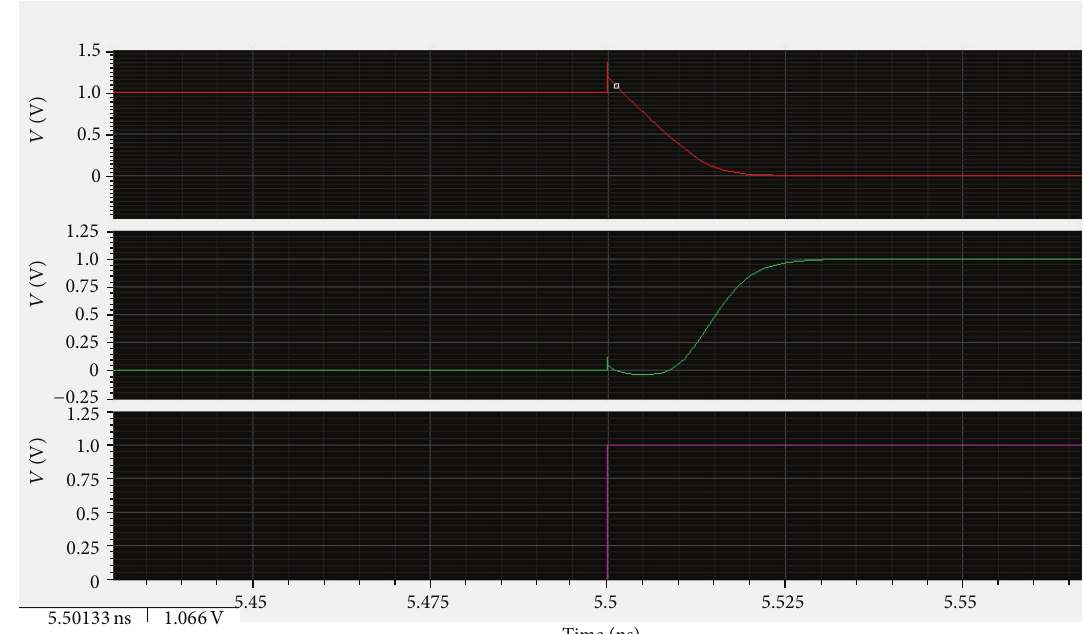
Figure 12: Skew reduction block output-transition from low to